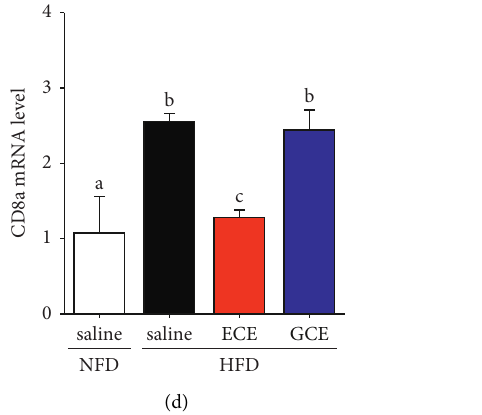
Figure 2: Effects of E . cava extract on macrophages and T-cell infiltration in visceral fat of high-fat diet- (HFD-) induced obese mice. (a) CD11b as a marker of total macrophage; (b) CD80 as a marker of M1 macrophage; and (c) CD206 as a marker of M2 macrophage expression mRNA levels were measured by qRT-PCR in visceral fat of standard normal fat diet with 0.9% saline (NFD/saline; open bar), HFD with 0.9% saline (HFD/saline; black bar), HFD with E . cava extract (HFD/ECE; red bar), and HFD with Garcinia cambogia extract (HFD/GCE; blue bar) groups. (d, e) CD8a and CD4 as T-cell expression levels were determined by qRT-PCR in visceral fat of the same groups. All mRNA levels expressed relative level and normalized ß -actin of the NFD/saline group. The same letters represent no significant difference ( p < 0 .